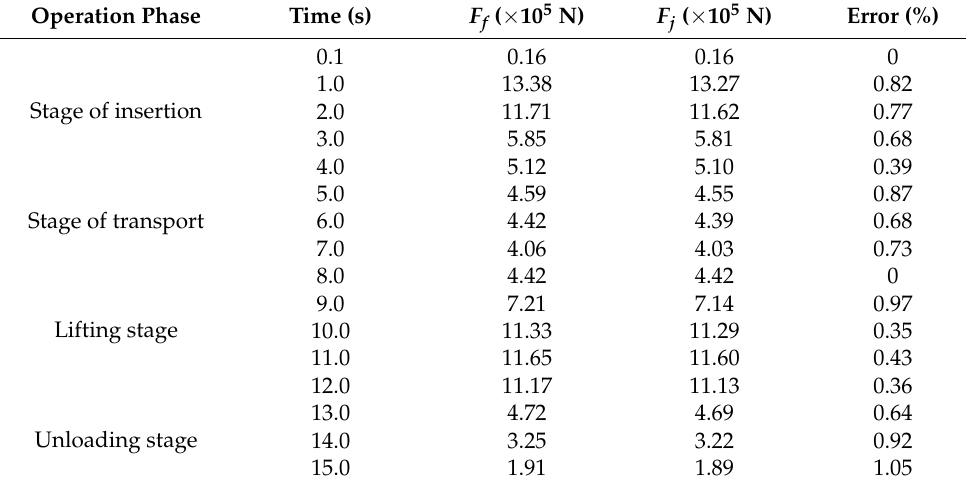
Table 2. Comparison of the simulation results and the calculated